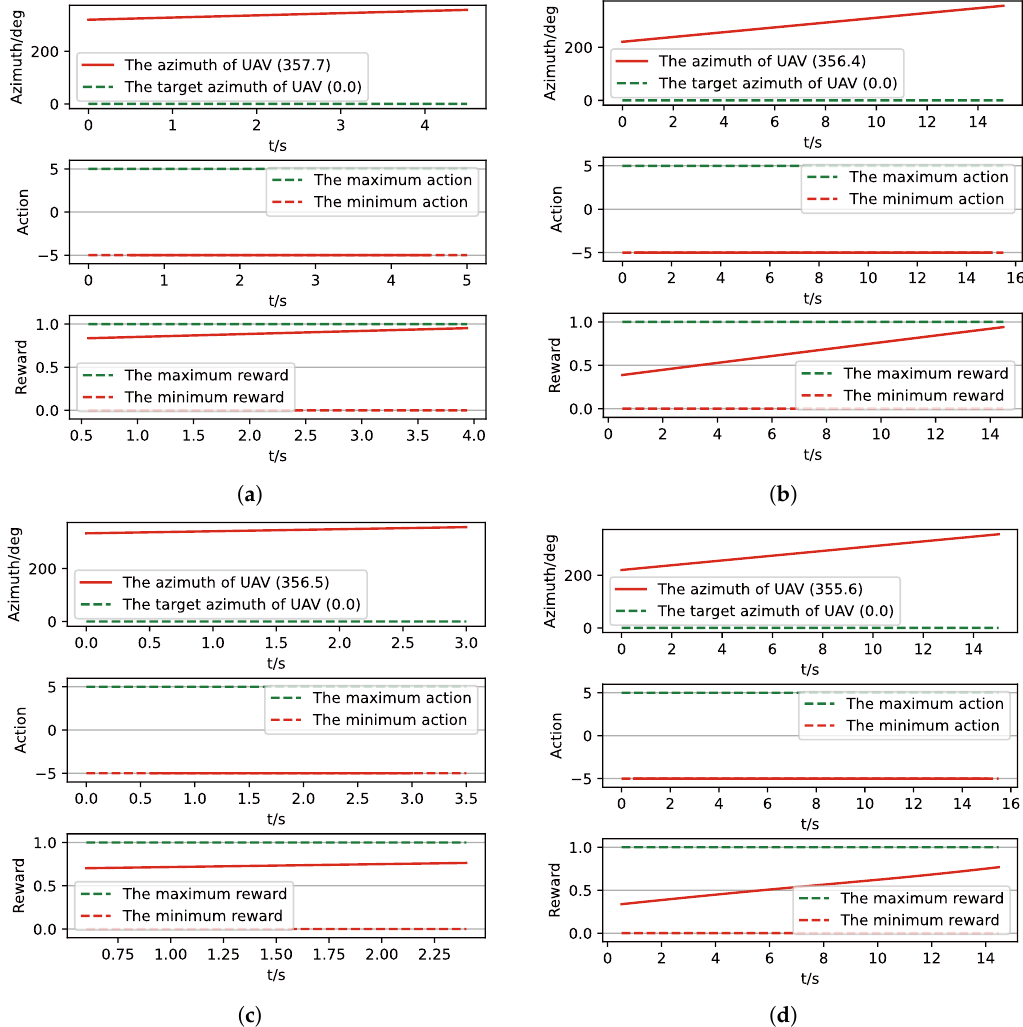
Figure 13. The parameters curve from MC experiments for the trained result of PER-DDPG: ( a ) The parameters curve of 1st experiment. ( b ) The parameters curve of 2nd experiment. ( c ) The parameters curve of 3rd experiment. ( d ) The parameters curve of 4th